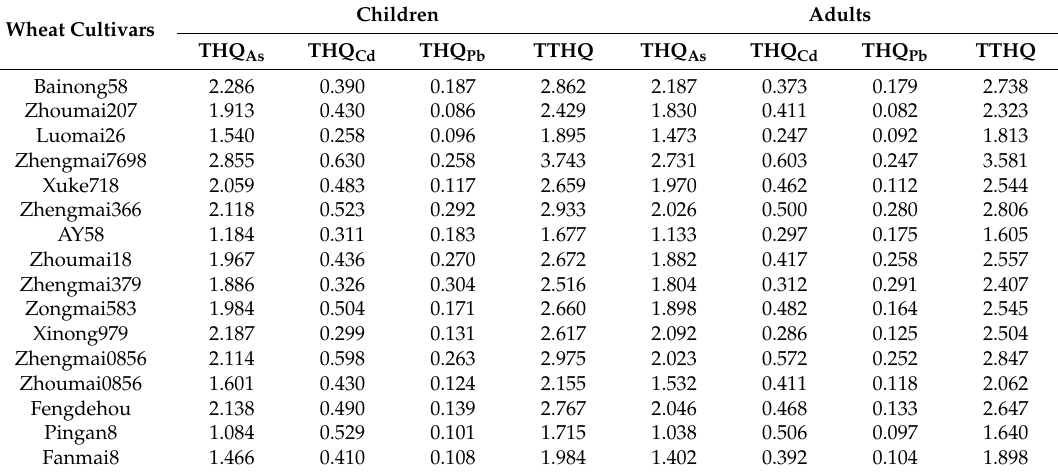
Table 5. THQ values of heavy metals via wheat consumption for children and adults. Wheat Cultivars